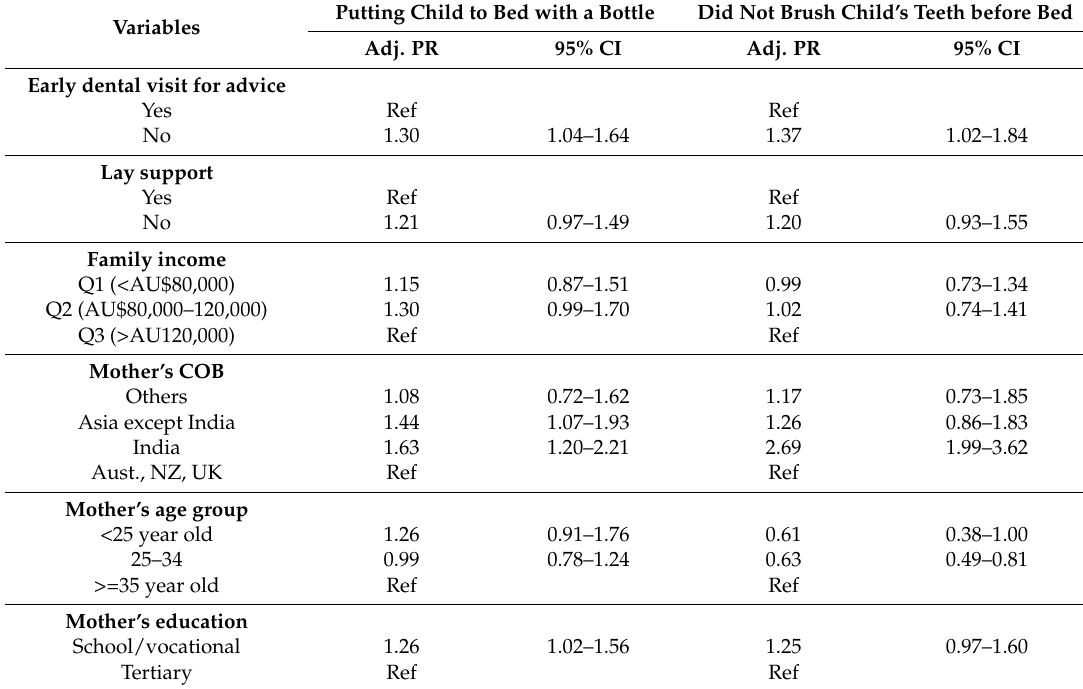
Table 3. Factors associated with the unfavourable oral health